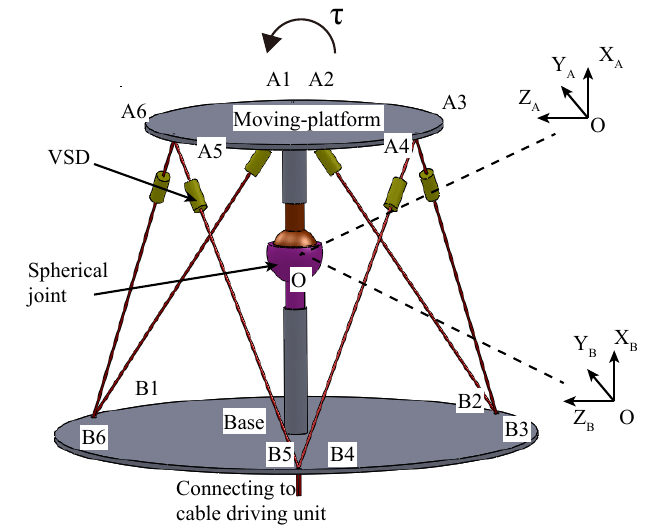
Figure 2. Concept design of the 3-DOF joint module